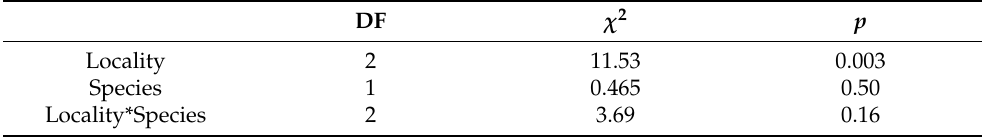
Table 1. Results of a Generalised Linear Model with a binomial distribution linked to a logit function examining the effect of locality, species and its interaction (locality*species) on the prevalence of blowfly larvae in tit nests, with and without interaction. Degrees of freedom (DF), chi-squared, and p -values are